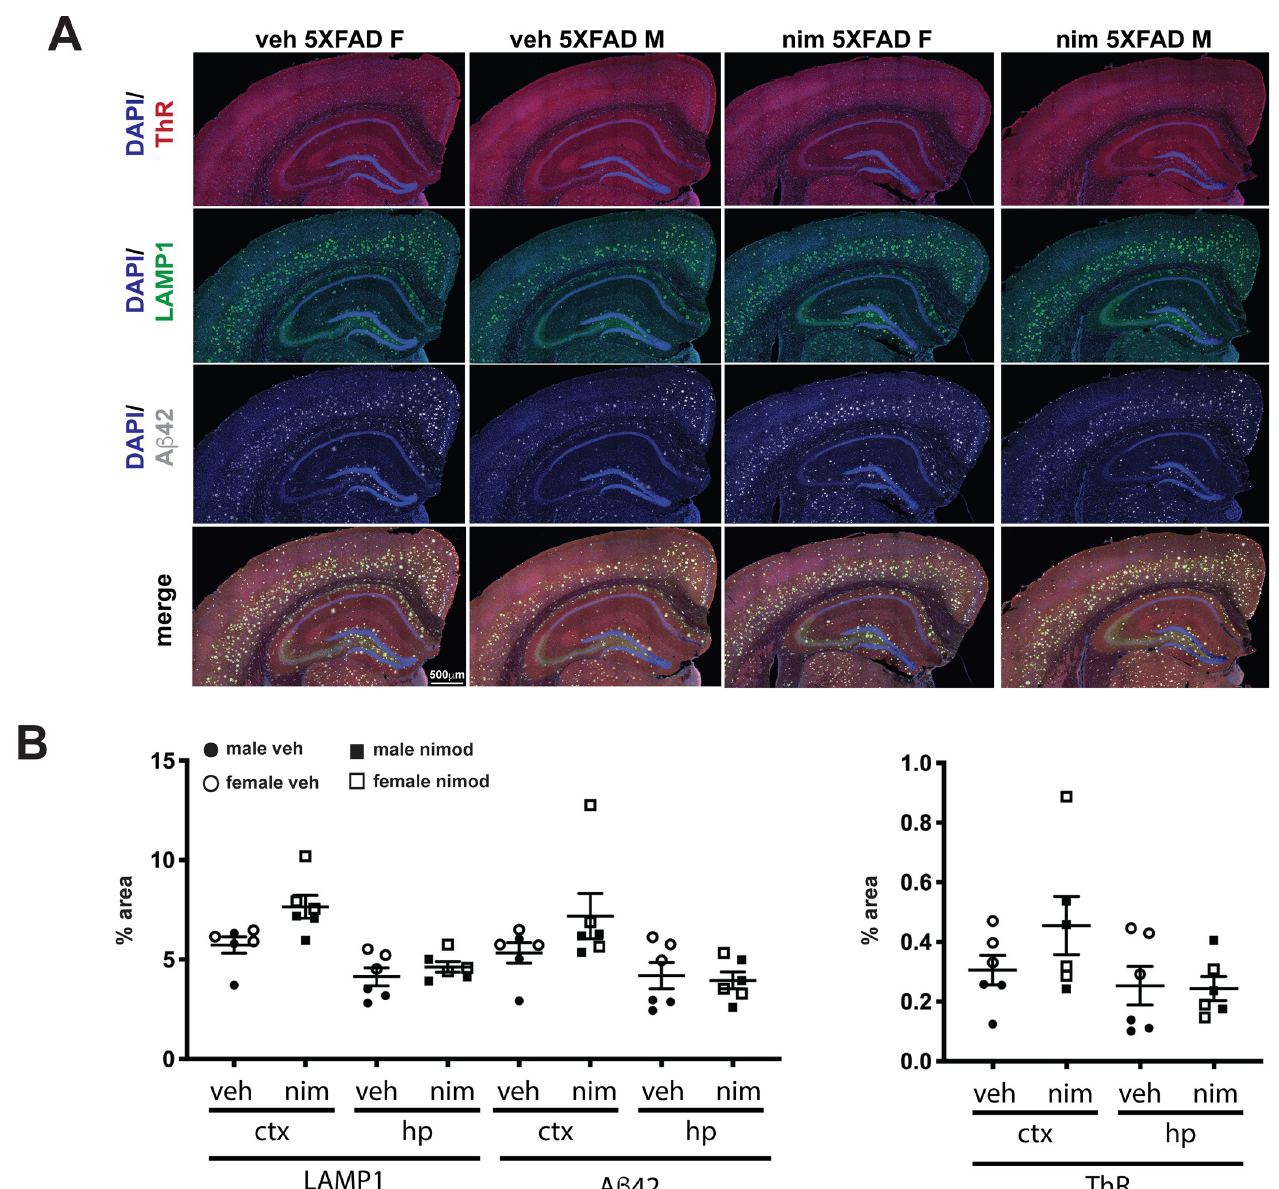
Fig 4. Nimodipine does not affect areas of amyloid plaques and dystrophic neurites in cortex or hippocampus. (A) Representative sections stained with Thiazine Red (red) for dense core plaques, anti-LAMP1 antibody (green) for dystrophic neurites, and anti- A β 42 (white) for all plaques and DAPI (blue) nuclei. B and C) Quantification of the percent area covered by LAMP1, A β 42 (B) or Thiazine Red (C) staining. Regions of interest were hand-drawn in cortex and hippocampus using Nikon NIS Elements software, and the percent area covered by each stain was calculated. There was no significant difference in LAMP1, A β 42 or Thiazine Red staining between the brains of vehicle and nimodipine-treated mice. We observed a trend for females to have higher levels of A β 42 and Thiazine Red, but was not statistically significant. ctx, cortex; hp, hippocampus; ThR, thiazine red. Error bars = SEM. Scale bar = 500 μ